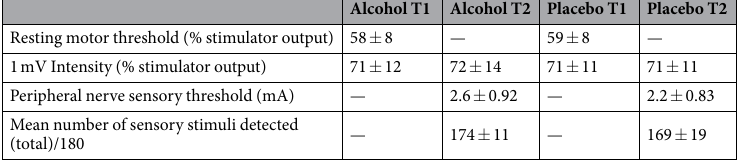
Table 2. Experimental characteristics for PAS. * Values are in Mean ± 1 Standard Deviation